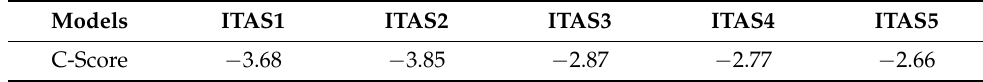
Table 3. Predicted I-TASSER models and C-scores.